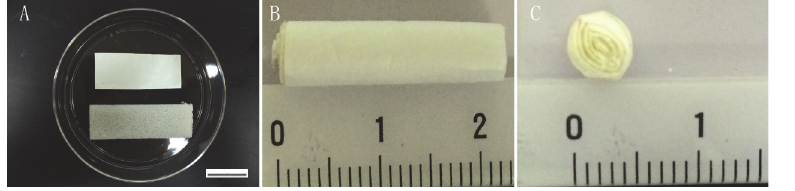
Fig 1. Preparation of 3D PLGA-PEG scaffolds. GS and PLGA-PEG film were used to assemble 3D PLGA-PEG scaffolds (A). PLGA-PEG film and GS were rolled together into a cylinder of 4mm diameter (B). The cylinder was cut transversely into 2 mm long cylinders